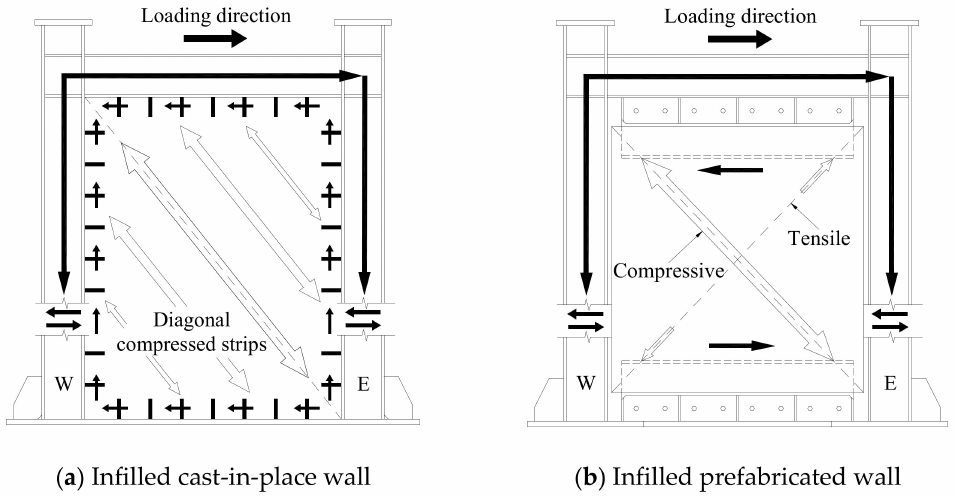
Figure 10. Transfer mechanism of the lateral